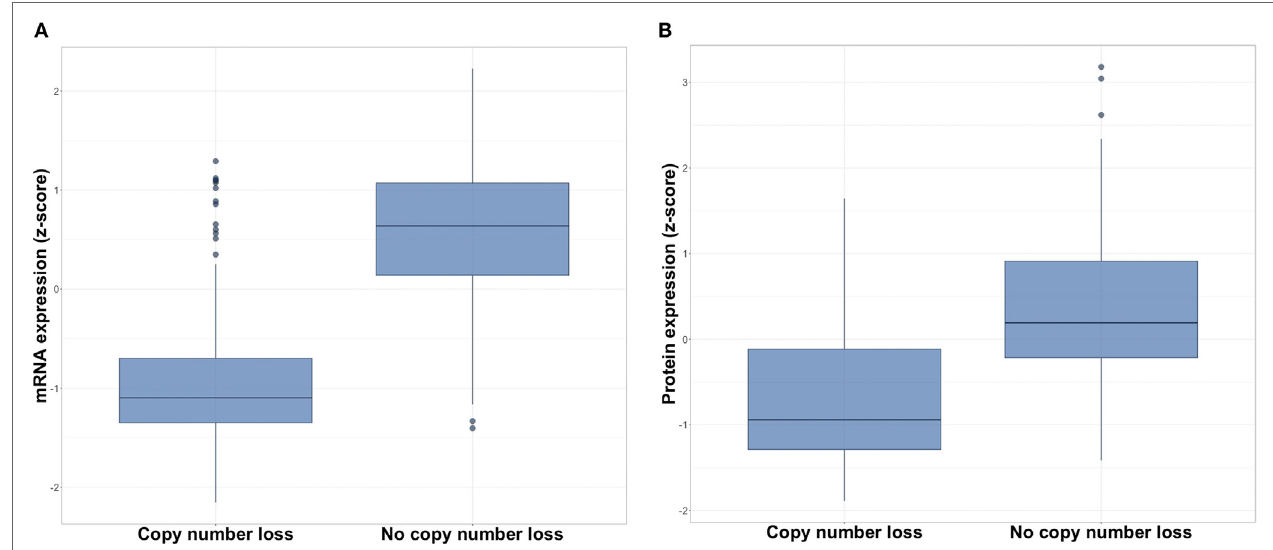
FigUre 1 | Expression of (a) CDKN2A mRNA and (B) p16 protein in copy number loss vs. non-copy number loss groups for all HPV-negative head and neck squamous cell carcinomas. FigUre 2 | Differences in (a) overall survival (OS) and (B) disease-free survival (DFS) between CDKN2A copy number loss and non-copy number loss groups for all tumors.